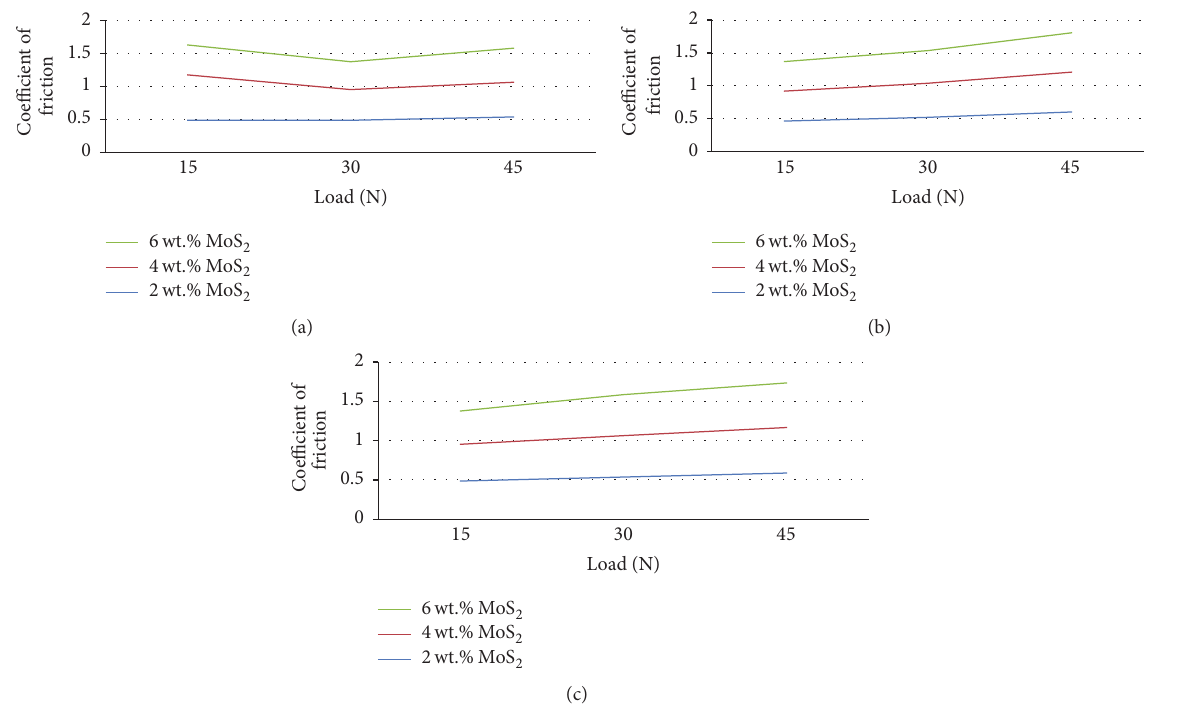
Figure 3: (a) Coefficient of friction of Al6061/12wt.% Al 2 O 3 /MoS 2 during sliding velocity of 1.25m/sec. (b) Coefficient of friction of Al6061/12 wt.% Al 2 O 3 /MoS 2 during sliding velocity of 2.50 m/sec. (c) Coefficient of friction of Al6061/12 wt.% Al 2 O 3 /MoS 2 during sliding velocity of 3.25